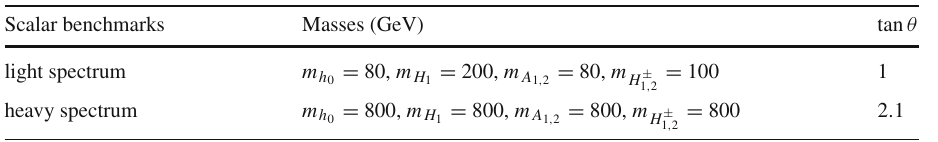
Scalar benchmarks Masses